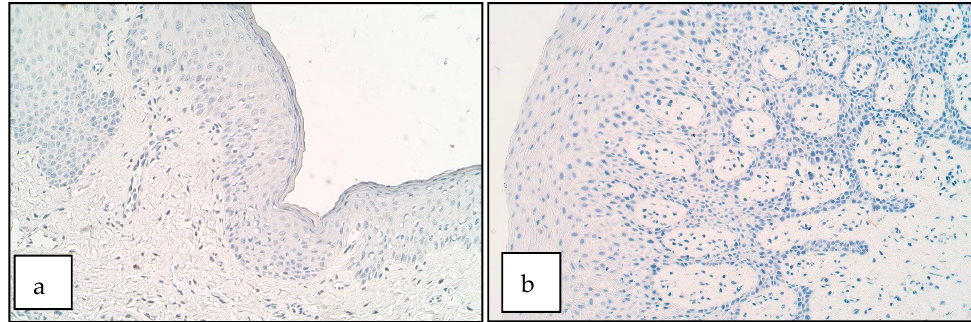
Figure 2. Immunoreactive structures for MSX2. ( a ) No positive structures for MSX2 in patient epi- thelium and connective tissue. MSX2 IHM, 200×. ( b ) No positive structures for MSX2 in control epithelium and connective tissue, MSX2 IHM, 200×.